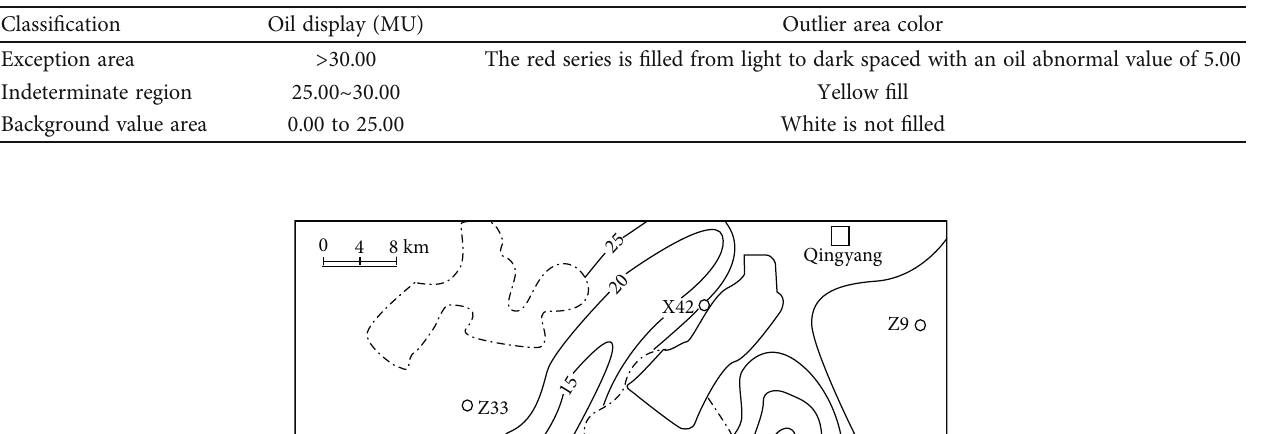
Table 1: Abnormal reference system of microbial oil in Changqing Oil fi eld.